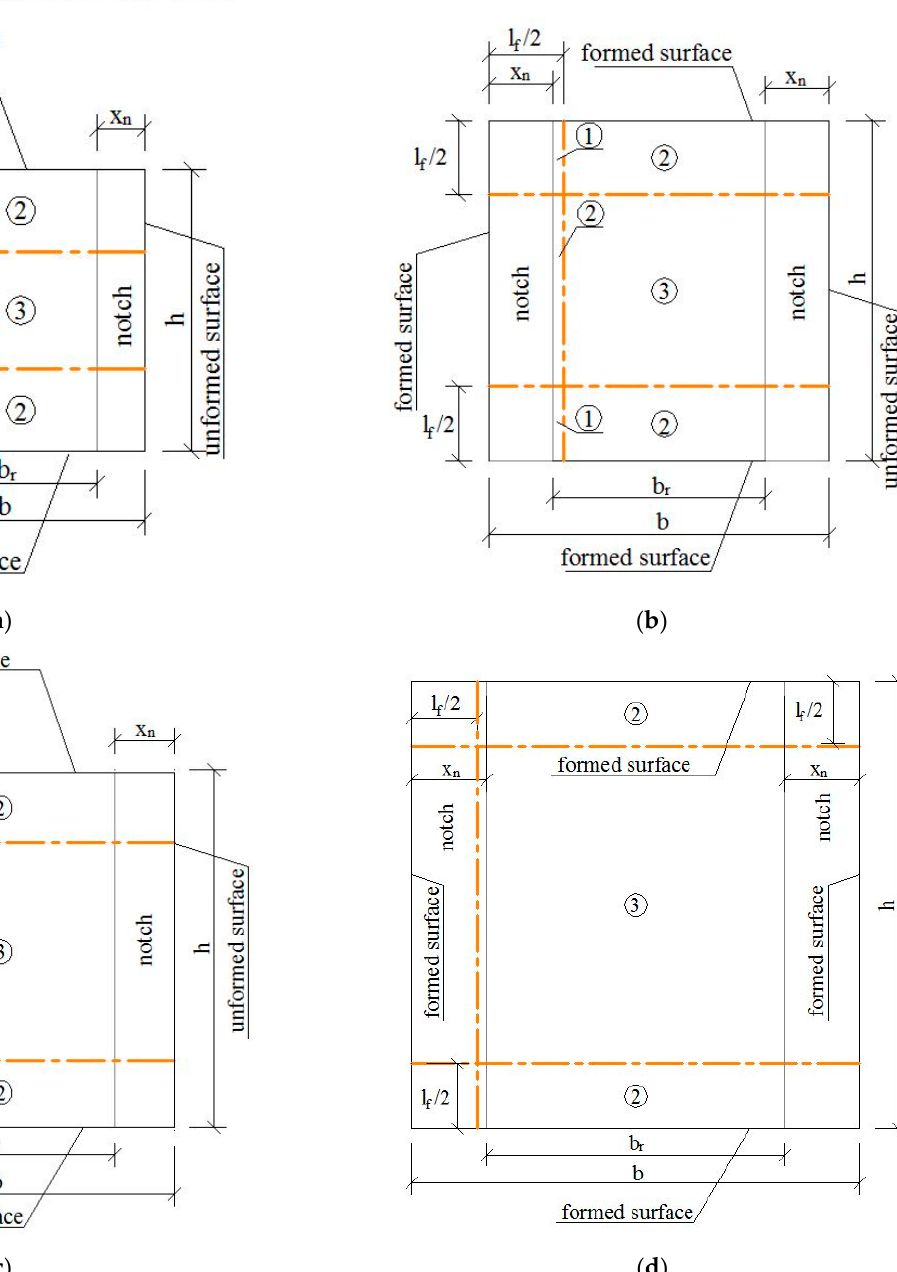
Figure 7. Edge effects of the sawing and wall on the cross-section areas of the reference prisms: ( a ) 6R, ( b ) 8R, ( c ) 9R and ( d ) 12R.